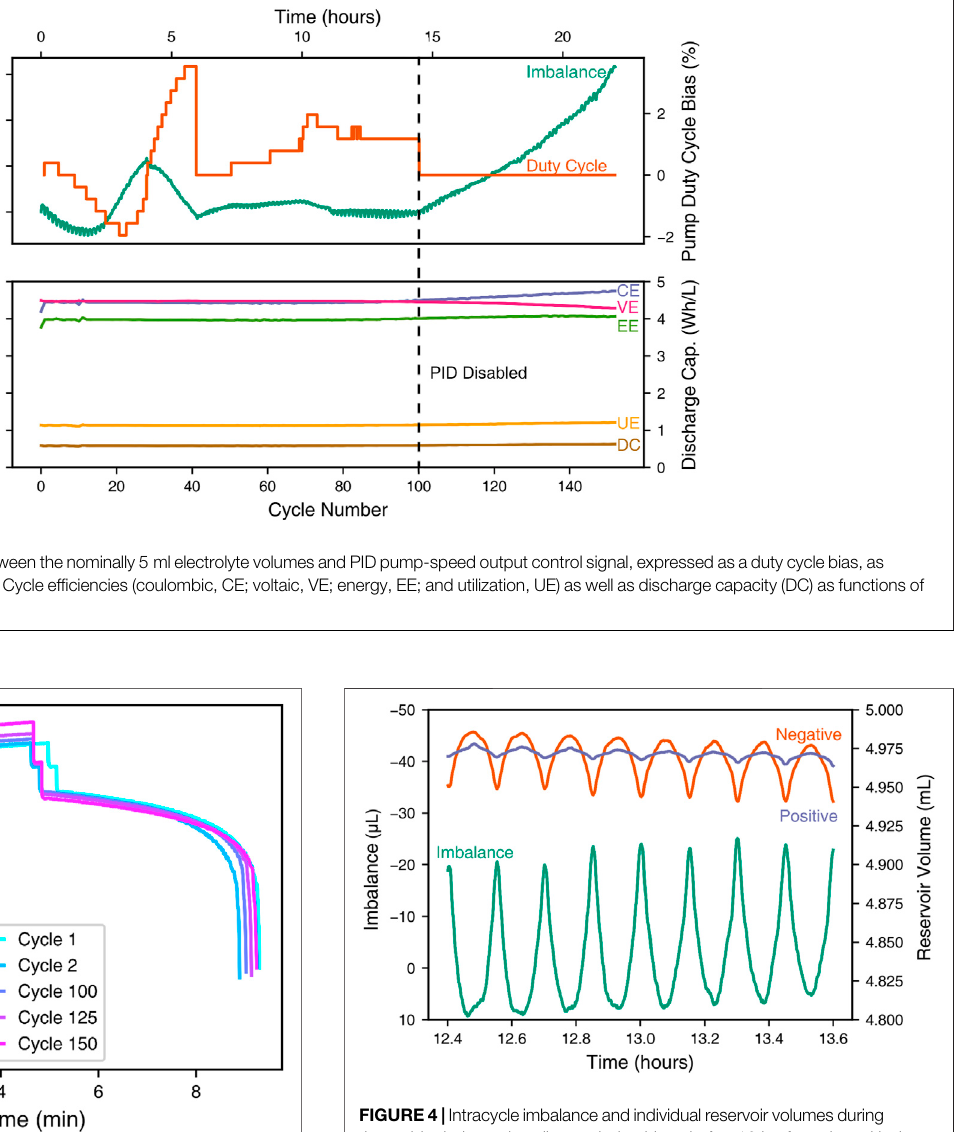
FIGURE 3 | Voltage pro fi les of charge/discharge cycles during active balancing. A 10 s open-circuit hold is performed between every charge and discharge step to track state-of-charge drift.